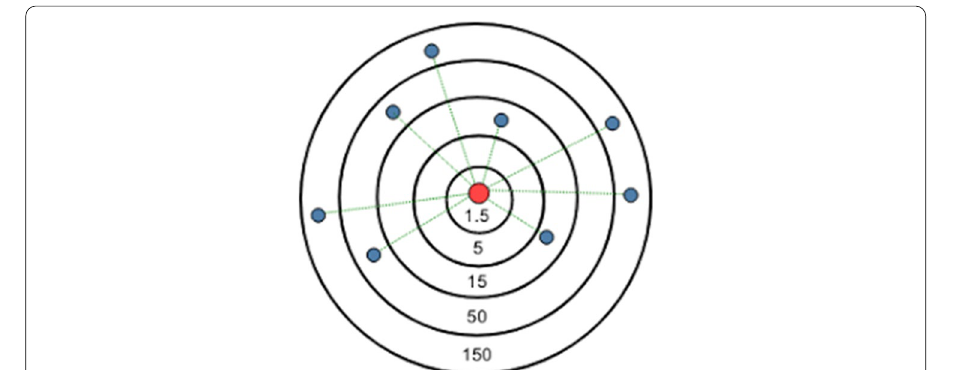
Fig. 1 Layered structure of the ego network. The red dot at the center corresponds to the